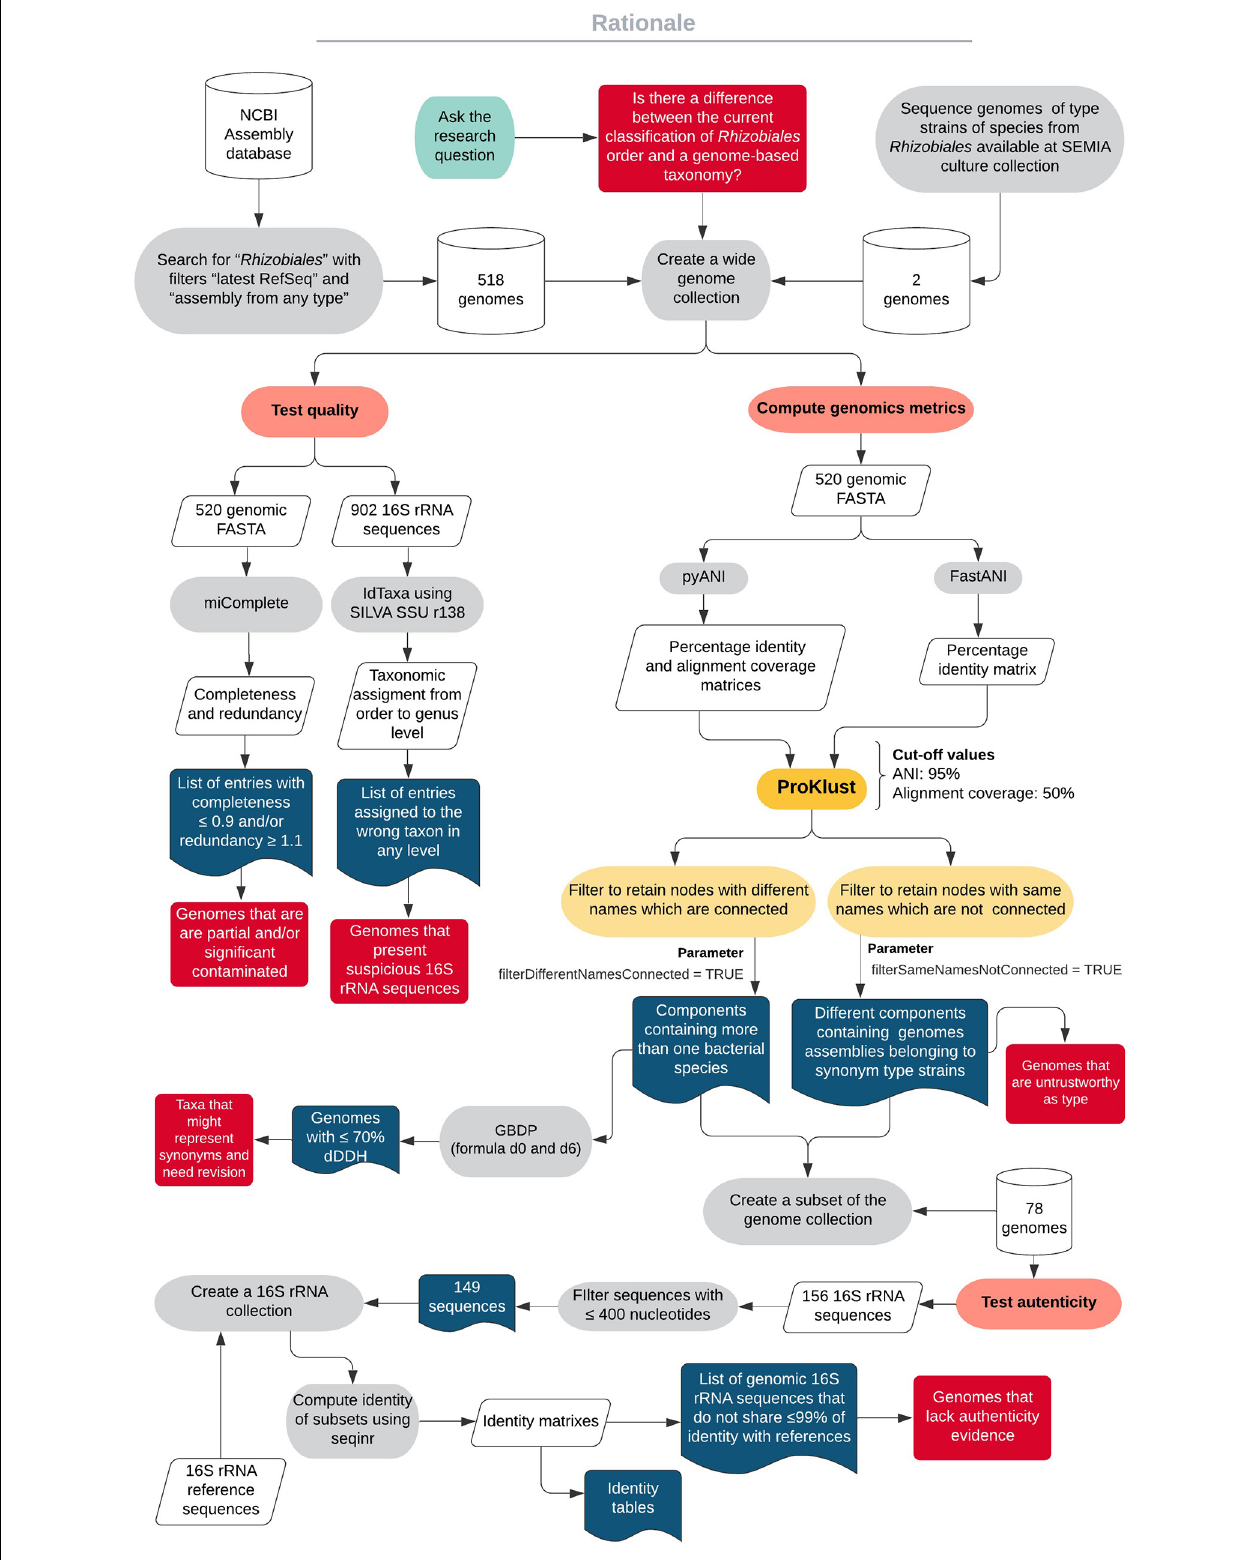
FIGURE 1 | A diagram showing the workflow of the